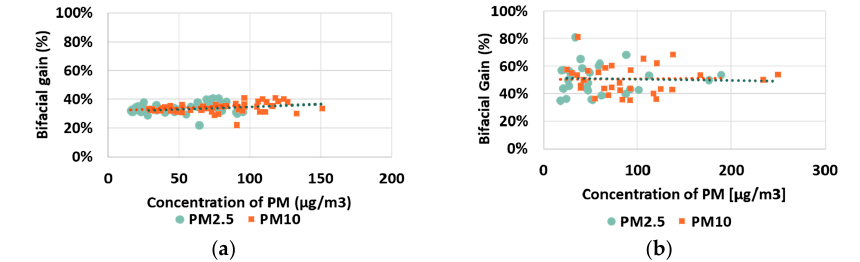
Figure 12. Bifacial gain based on the concentration of PM: ( a ) clear sky; ( b ) overcast. Table 8. Bifacial gain based on the concentration of PM at specific points. PM 2.5